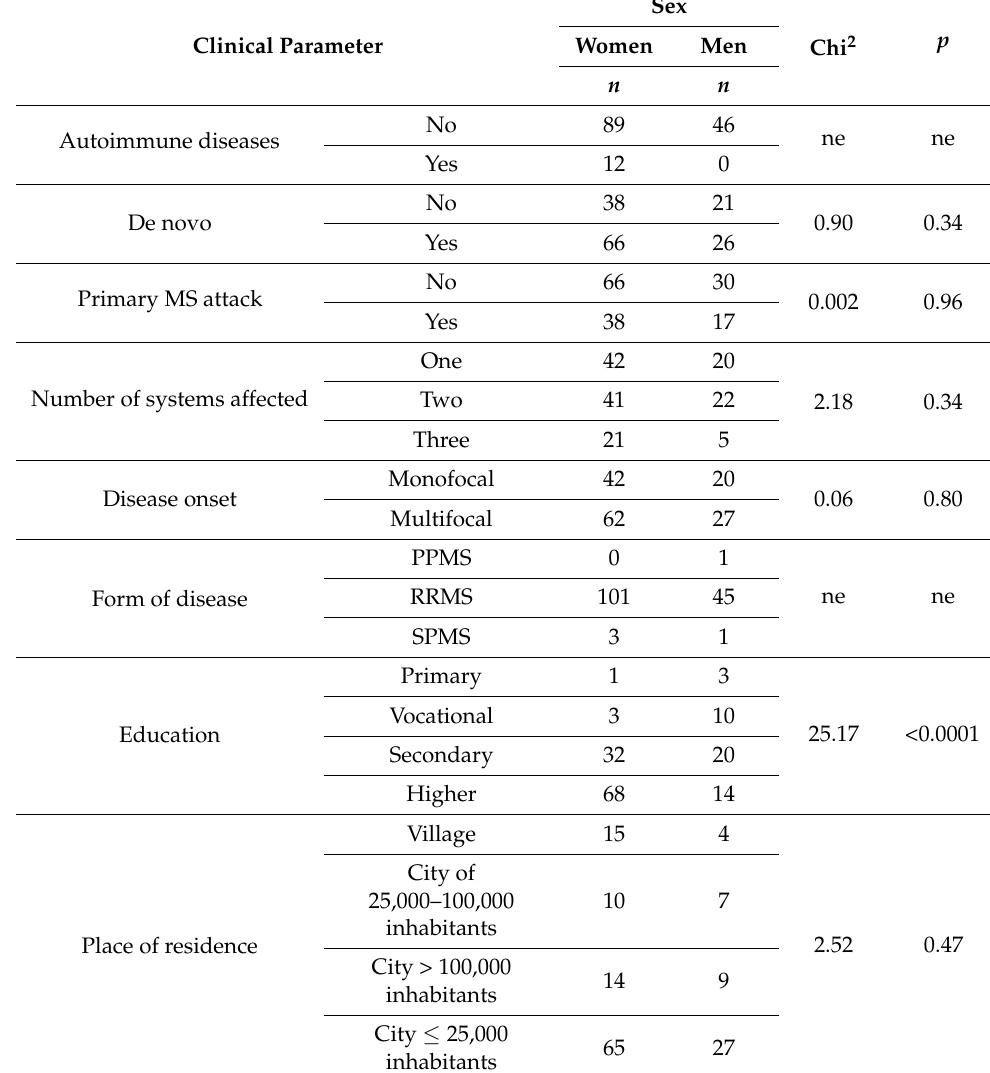
Table 2. Qualitative clinical and sociodemographic data with regard to